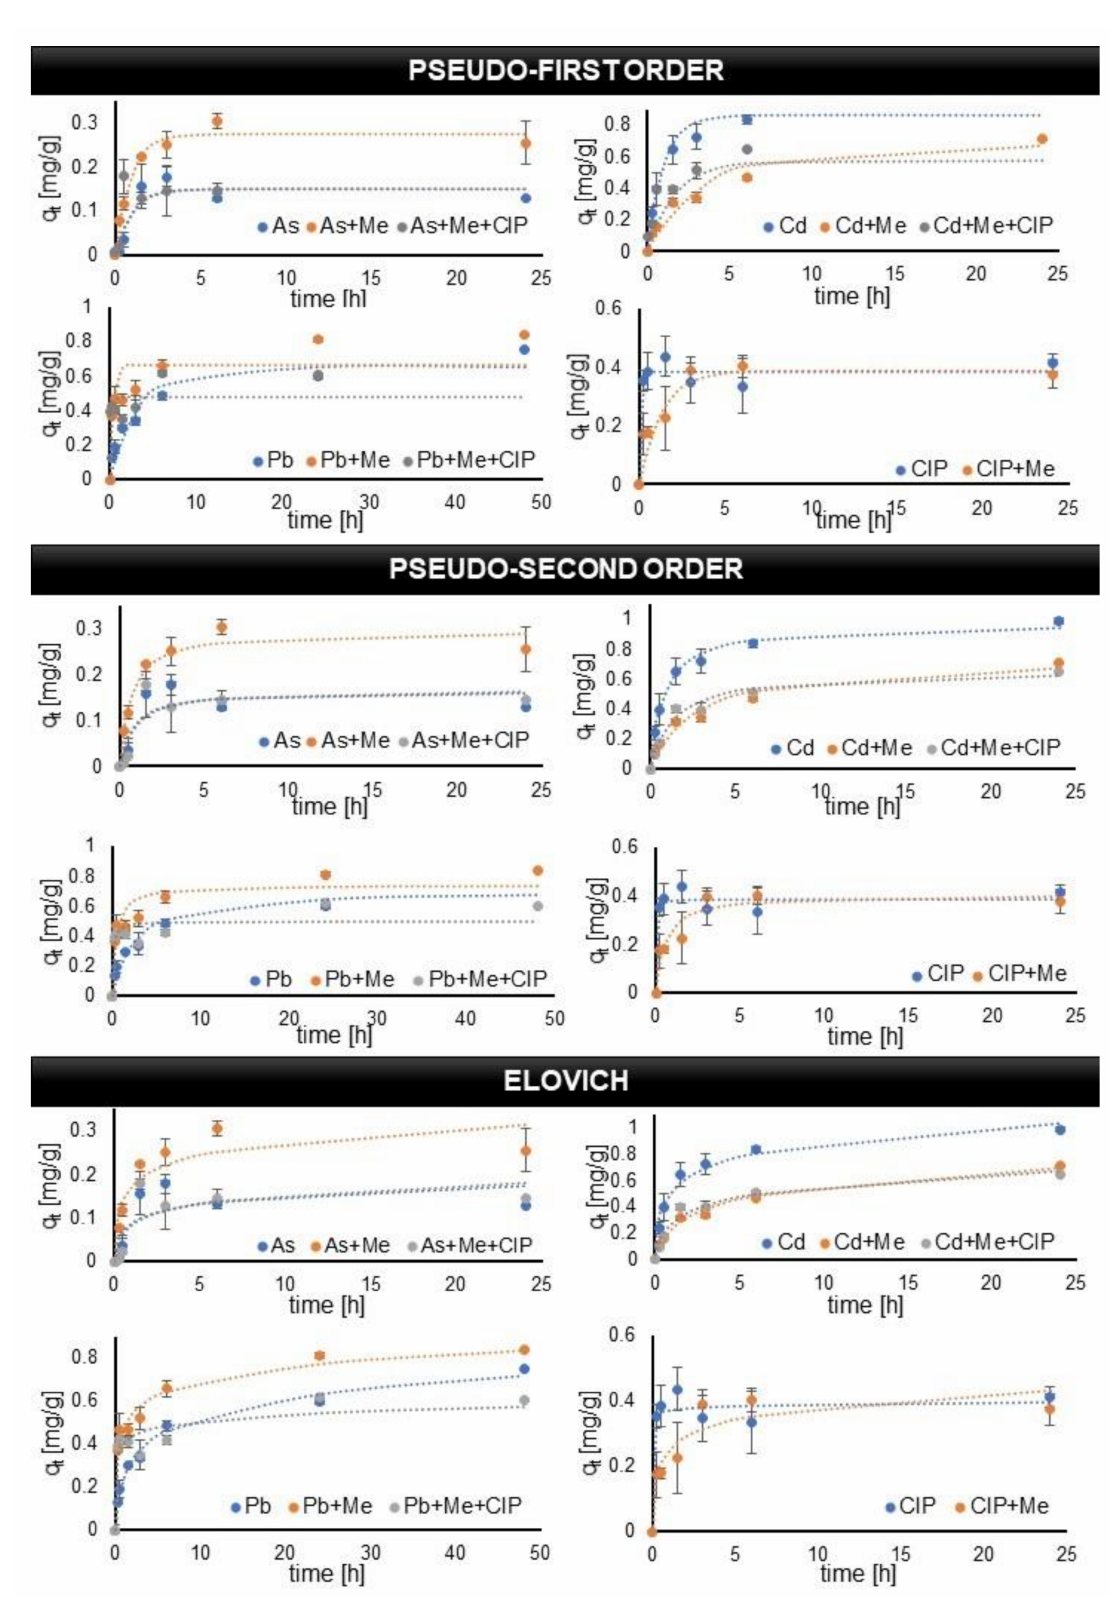
Figure 5. Kinetic curves of adsorption models, i.e., pseudo-first order, pseudo-second order and Elovich, for the tested pollutants on